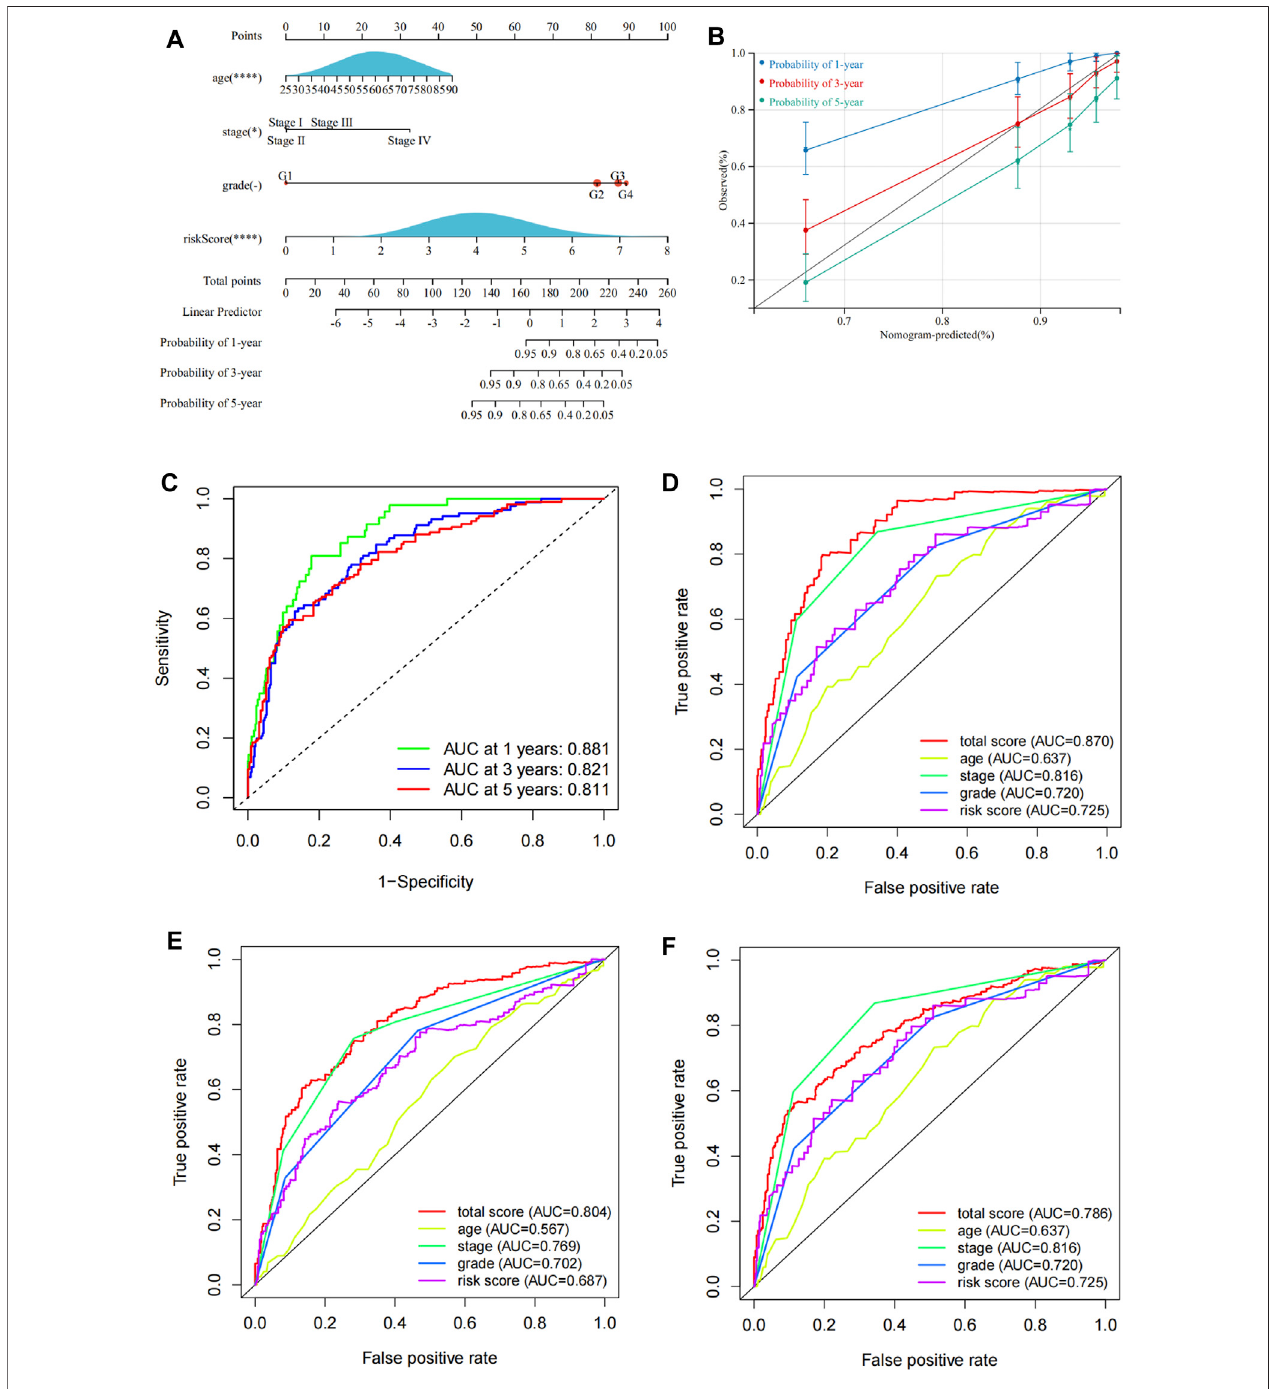
FIGURE6 | Construction of anomogram for prognosisprediction. (A) Prognostic nomogram including risk scores and other clinical factors. (B) Calibration curves of the 1-, 3-,and 5-year OS. (C) ROCcurvesto evaluate the1-, 3-, and 5-year OS predictive ef fi ciency. (D – F) ROCcurves tocompare the predictive ef fi ciencybetween the nomogram and other clinical factors for the 1-, 3-, and 5-year